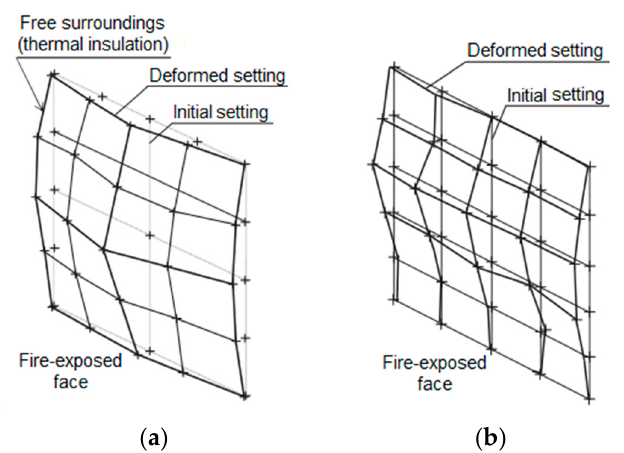
Figure 2. Deformations endured by fire-exposed masonry ( a ) non-load bearing wall and ( b ) load-bearing wall, as per Nguyen and Meftah [9].